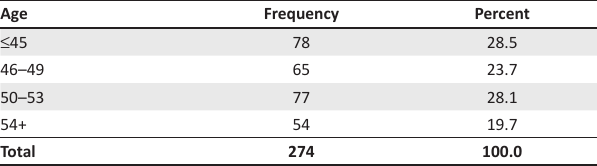
TABLE 4: Frequency table showing the age groups of respondents in the sample.